Question: What direction does the quantity move in — increasing or decreasing?
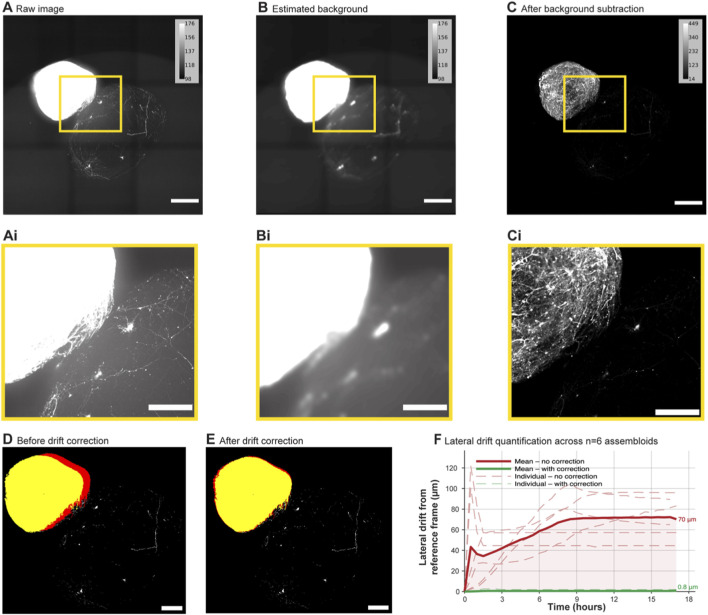
Answer: decreasing